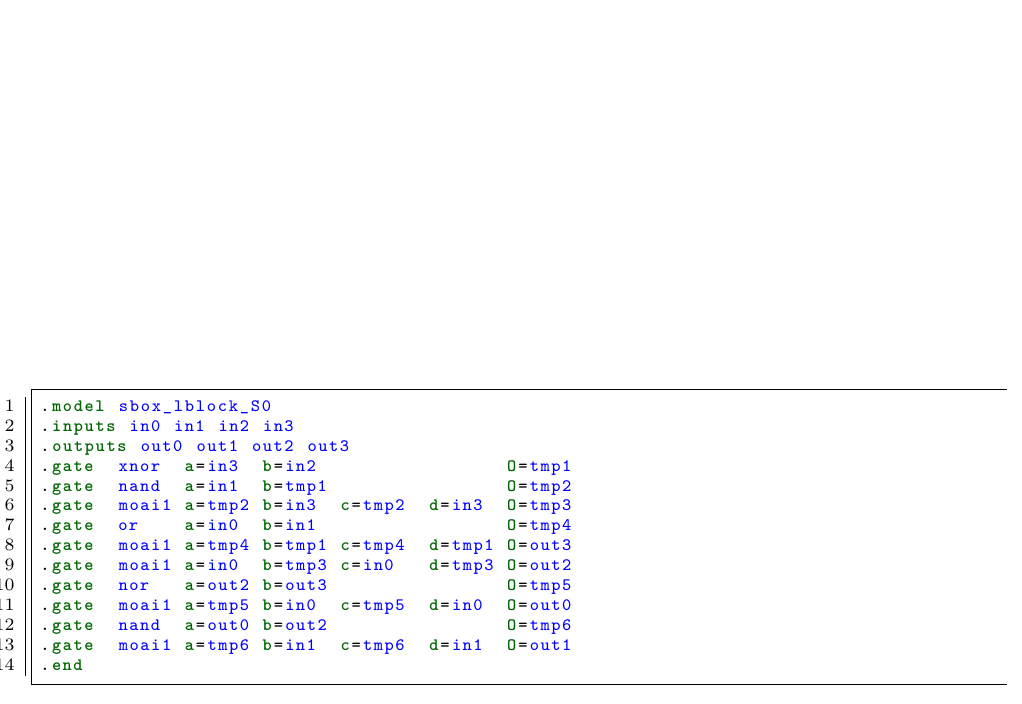
Figure 8: Area-optimized hardware implementation of Rectangle Sbox using 18.33 GE with the standard cell library of the UMC 180nm logic process.